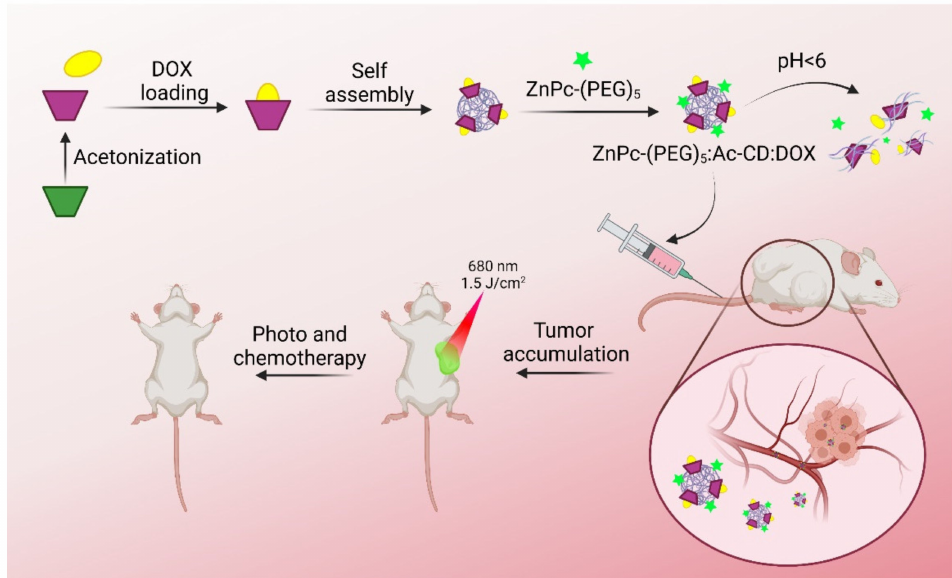
Figure 3. Construction of the nanosystem ZnPc-(PEG) 5 :Ac-CD:DOX with pH and light sensitivity for in vivo synergistic chemo- and photo-therapy of tumors in an H22 tumor-bearing mice model [170]. Created with